Question: Summarize what this figure shows in one sentence.
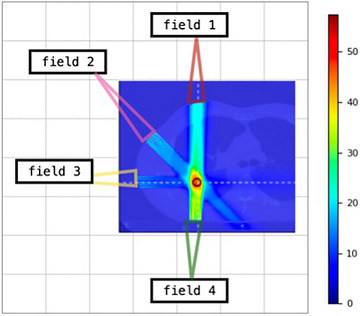
Answer: Illustrative example of the irradiation geometry adopted for preliminary minibeam VHEE simulations in non‐small‐cell lung cancer. The VHEE dose map is shown superimposed on the CT scan, with the PTV contours highlighted in black and the number of irradiation fields indicated. The dose distribution is shown for illustrative purposes only to visualize the beam geometry and mini‐ beam configuration, and does not represent a clinically optimized treatment plan.